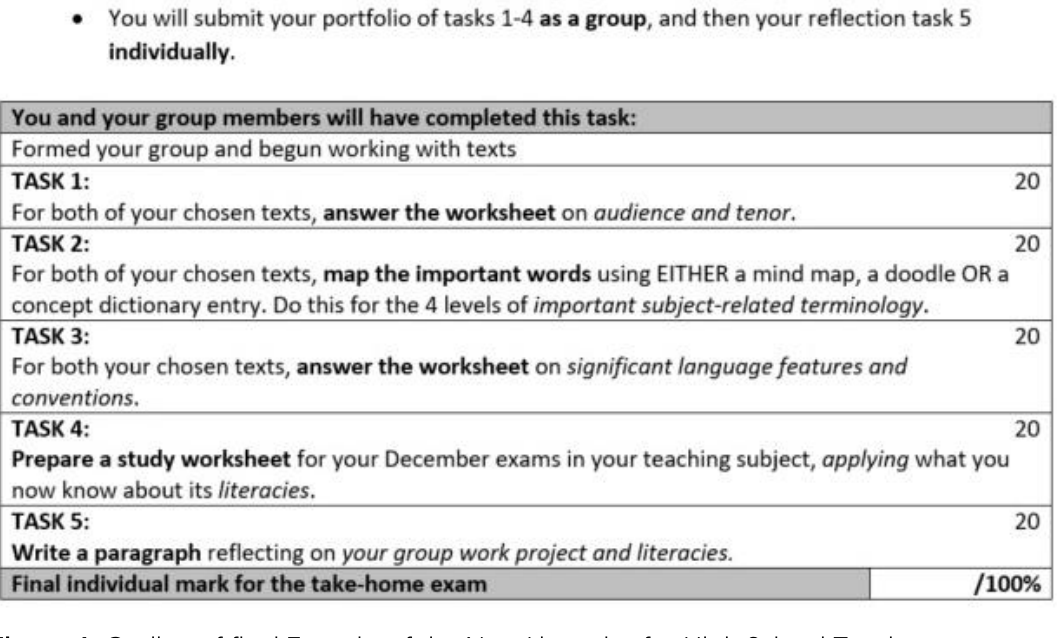
Figure 1 : Outline of final 7 weeks of the New Literacies for High School Teachers course Affordances and